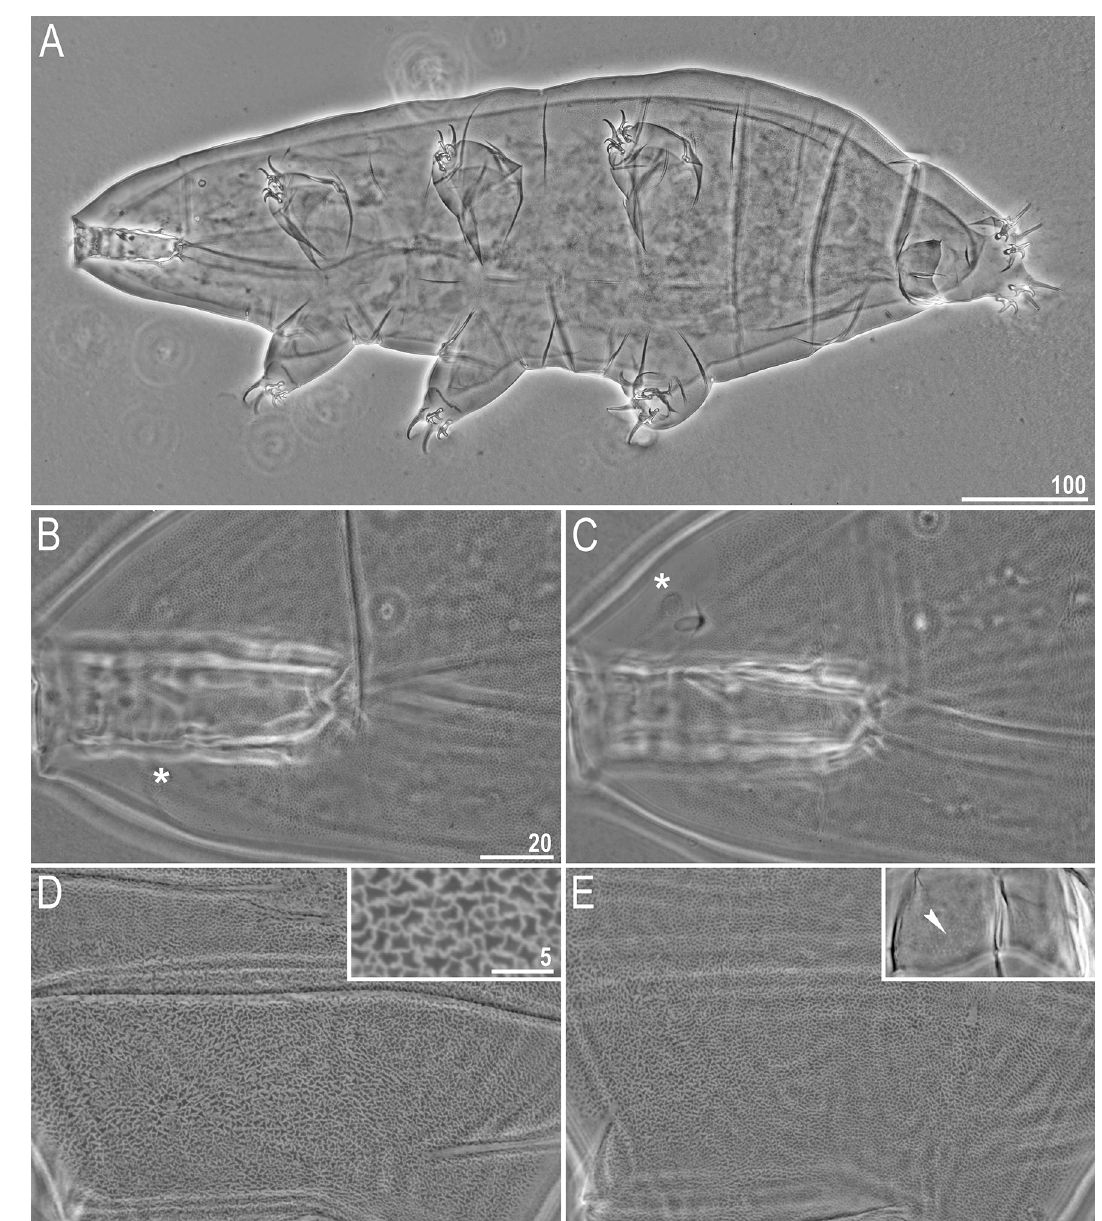
Figure 10. Milnesium sp. nov. CO.004 from Colombia, with irregular polygonal granulation visible on the entire body in PCM. ( A ) habitus, ventral view, with granulation visible in the caudal part of the body; ( B , C ) the same part of the head in dorsal and ventral view, respectively (asterisks indicate small smooth areas of the cuticle close to the lateral papillae); ( D , E ) the same fragment of the caudal part of the body between legs III and IV, in the dorsal and ventral view, respectively; the insert on D shows a magnified fragment of the dorsal cuticle sculpturing; the insert on E shows the pseudopores visible on the cloaca. The scale bar in μm; scale the same on the ( B – E